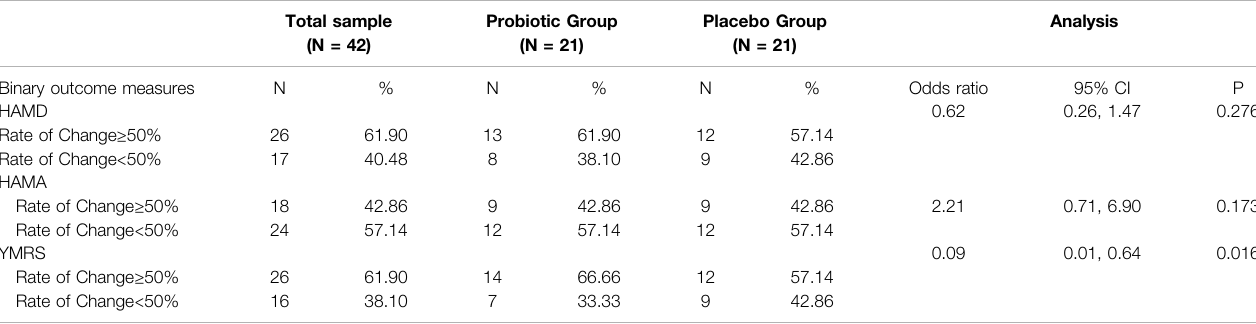
TABLE 2 | Outcome measures in a study of probiotic and placebo therapy in bipolar patients.